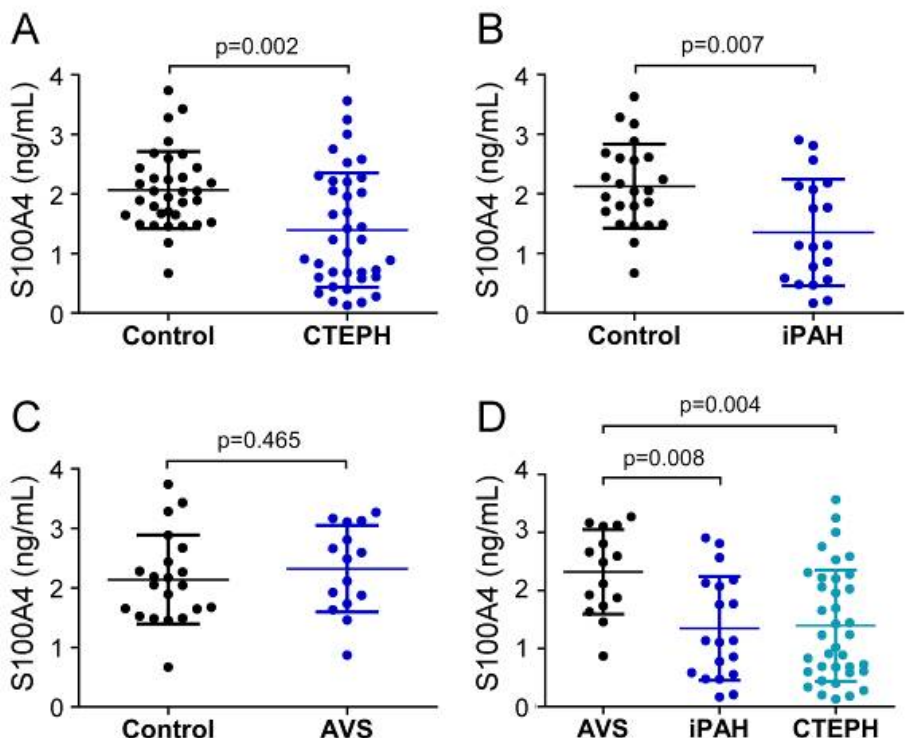
Figure 2. Serum concentrations of S100A4 in ( A ) CTEPH, ( B ) iPAH, and ( C ) AVS patient groups and controls. ( D ) Comparison of S100A4 levels between AVS, iPAH, and CTEPH patients. Each dot represents one donor. Arithmetic means and standard deviations are indicated by horizontal lines. Patient groups were compared to controls by Mann–Whitney U test. One-way ANOVA with Bonferroni–Holm post hoc test was used to compare 3 groups.